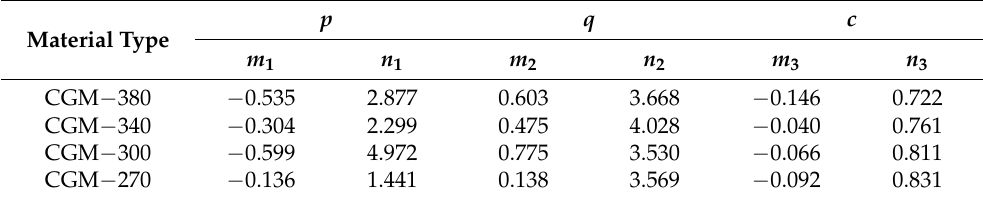
Table 3. Regression results of coefficients m i and n i ( i = 1, 2,